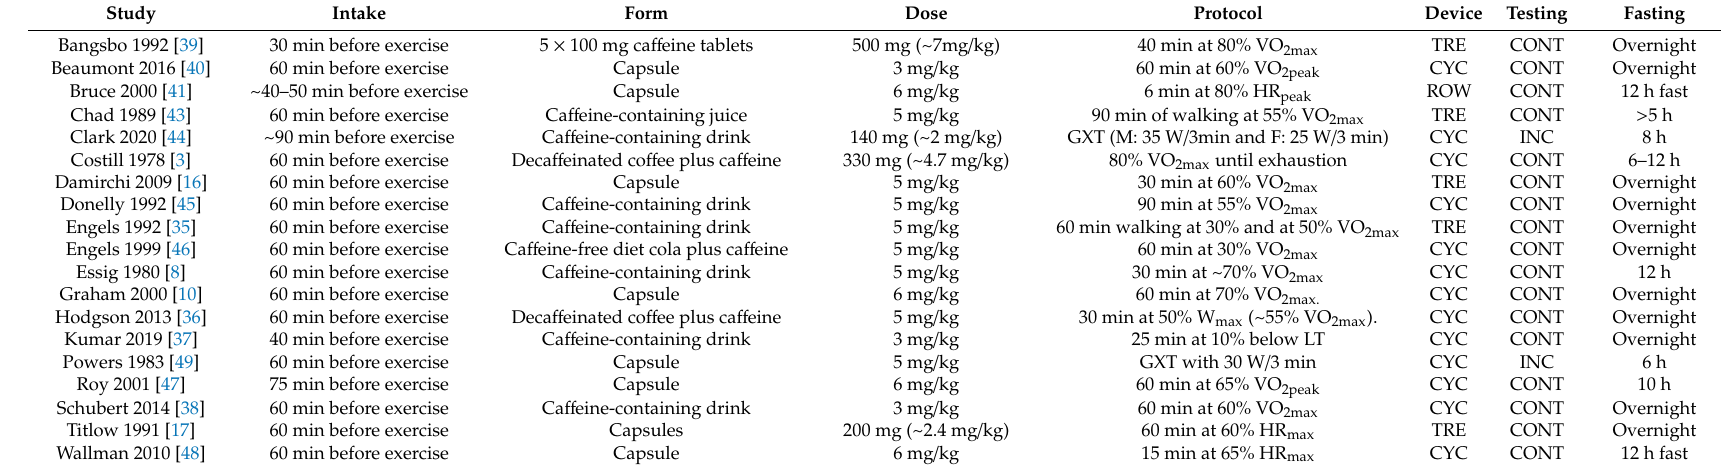
Table A1. Main characteristics of the interventions and protocols of the selected